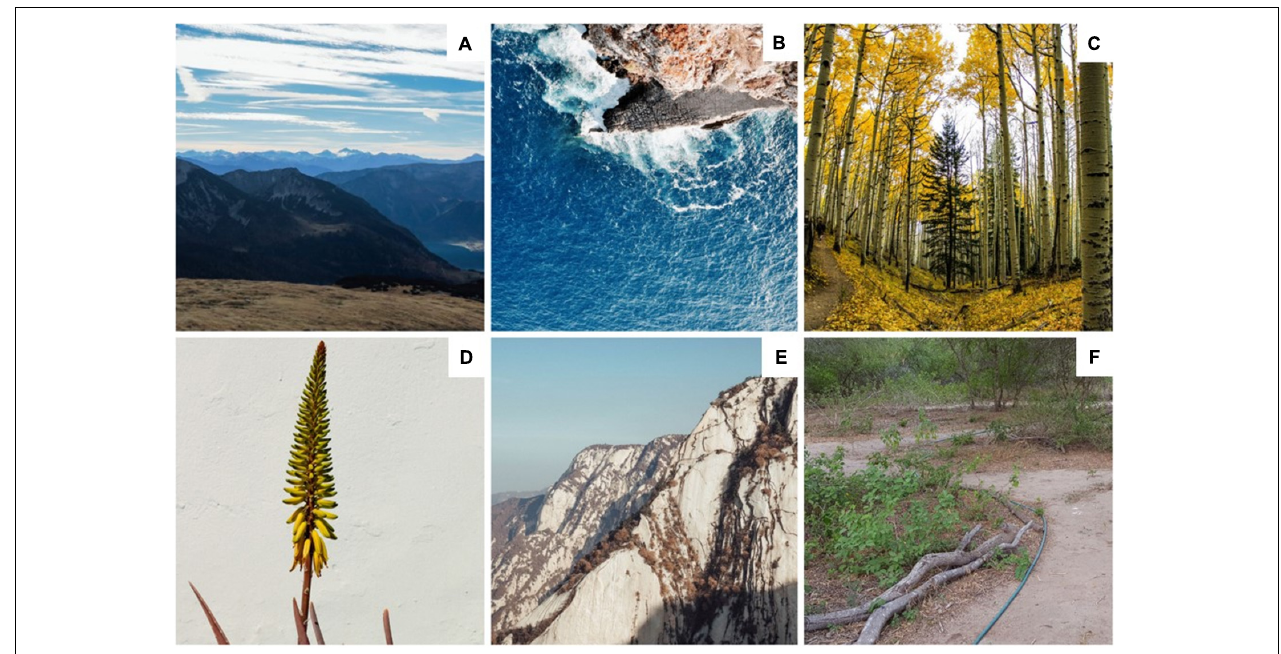
FIGURE 1 | Semantic and framing features. (A) Atmospheric perspectives, (B) bodies of water, (C) canopies, (D) close-range views, (E) mountains, and (F) unnatural elements.